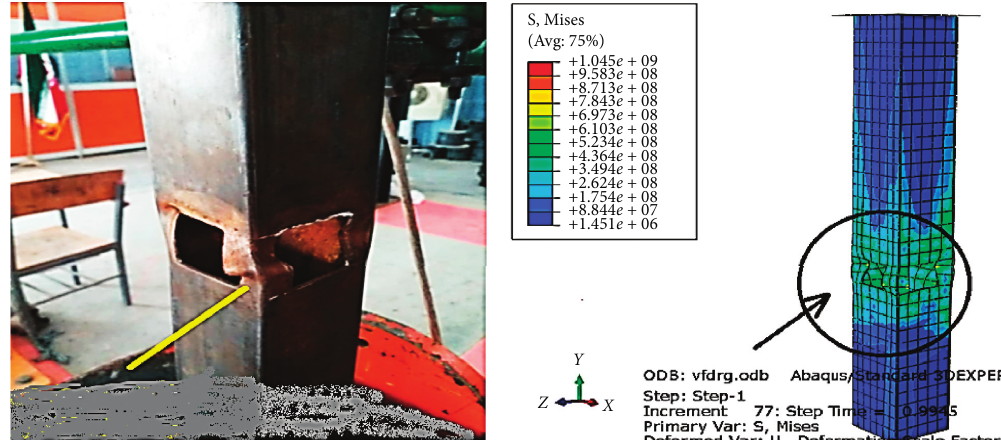
Figure 13: Comparison of a defective sample in two adjacent walls of a short steel column.